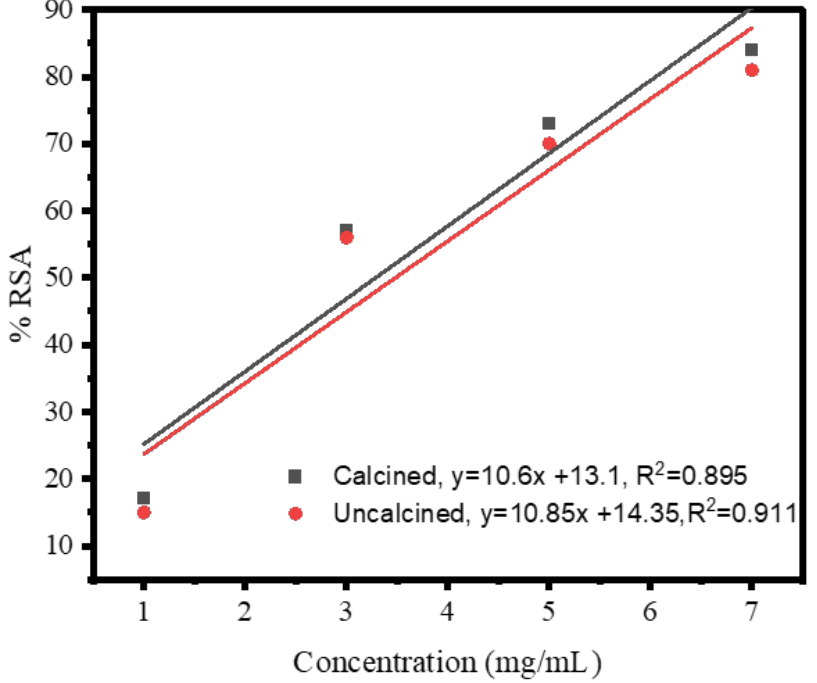
Figure 9. Graphical representation of antioxidant activity of green-synthesized calcine and non-calcined Ag NPs.